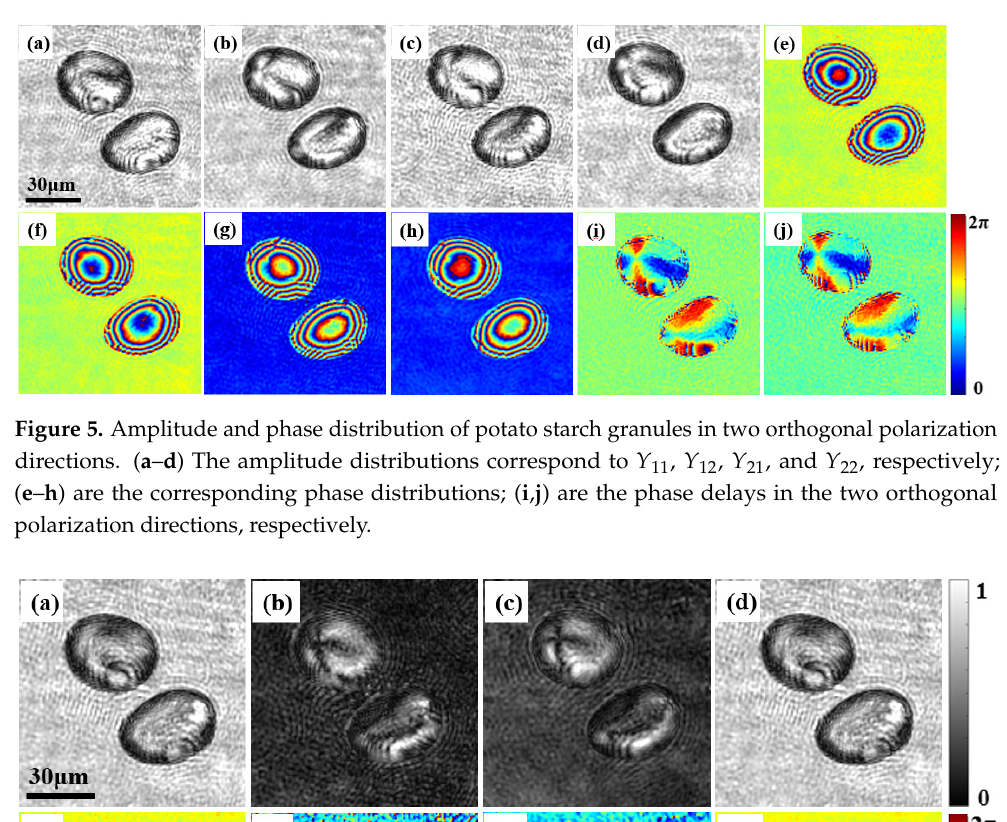
( 1 ) ( 1 ) ( 2 ) ( 2 ) T , , and (2) T , respectively; ( e – h ) are the corre- xx , T xy , T yx , and T yy , respectively; ( e – h ) are the corresponding xx yy